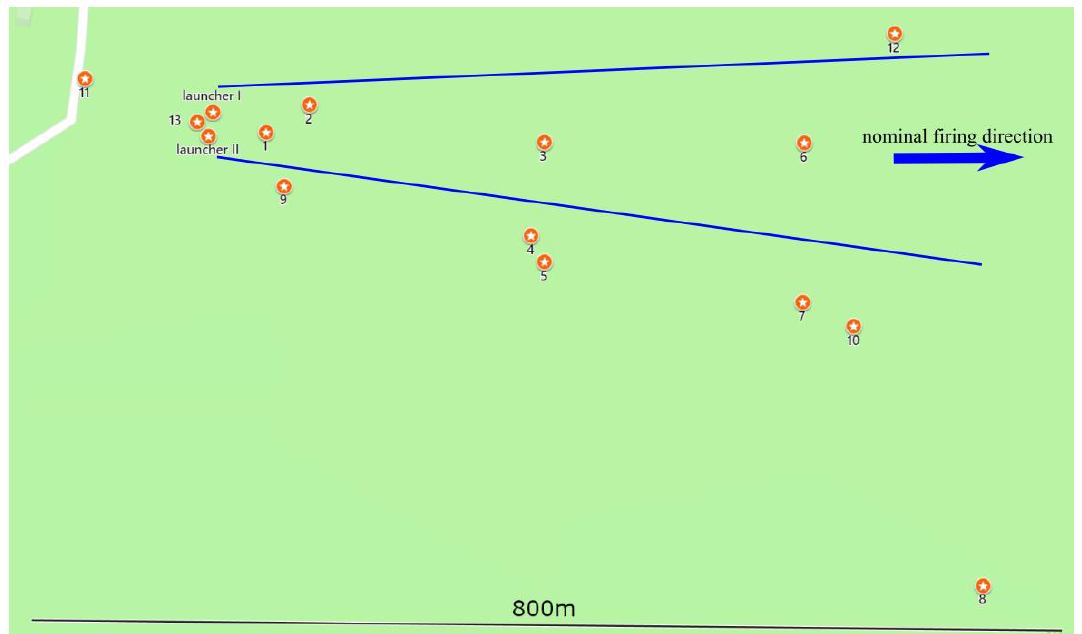
Table 5. Summary of the flight tests results.